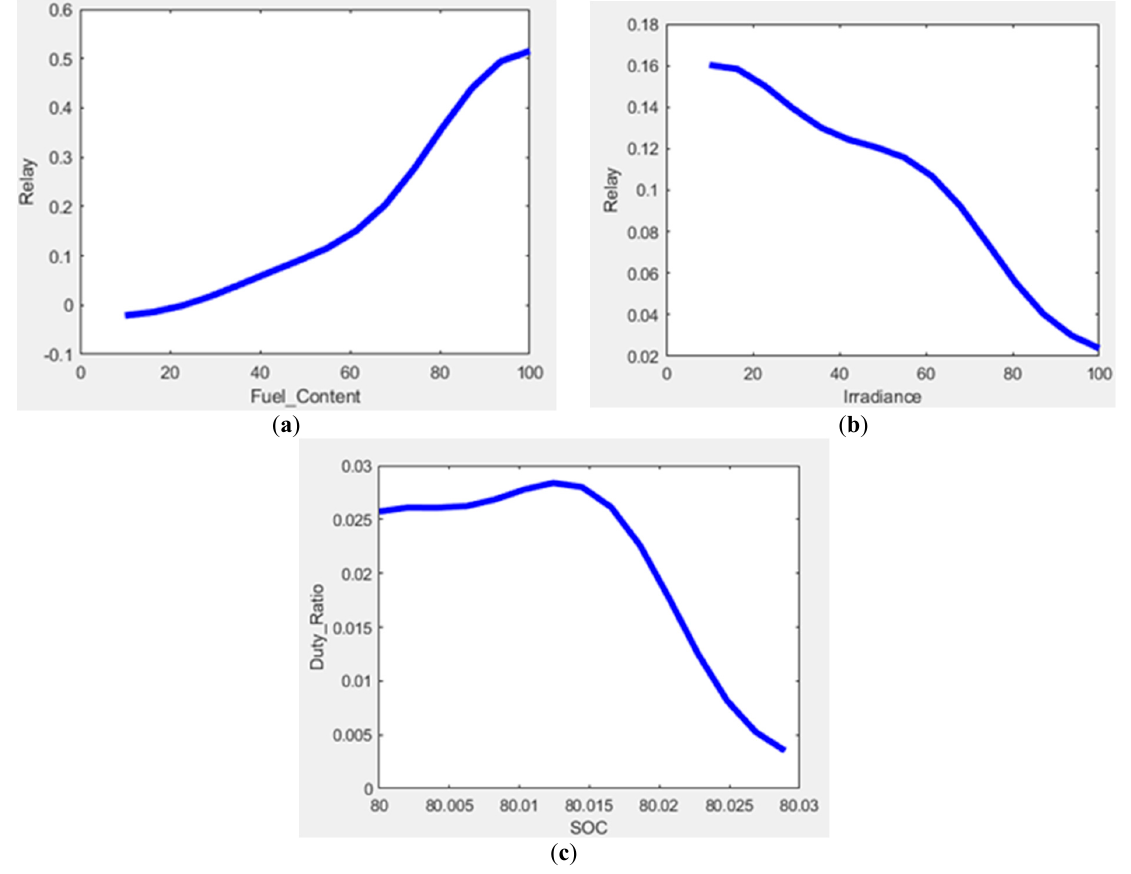
Figure 39. Correlation between the variables ( a ) Relay and Fuel Content, ( b ) Relay and Irradiance, and ( c ) duty ratio and SOC.